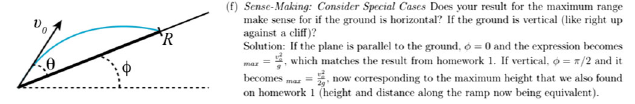
FIG. 4. Left: a diagram of the angled-ground projectile prob- lem, drawn here for clarity. Right: the solutions to part f) of the angled-ground projectile problem, as presented by Hahn